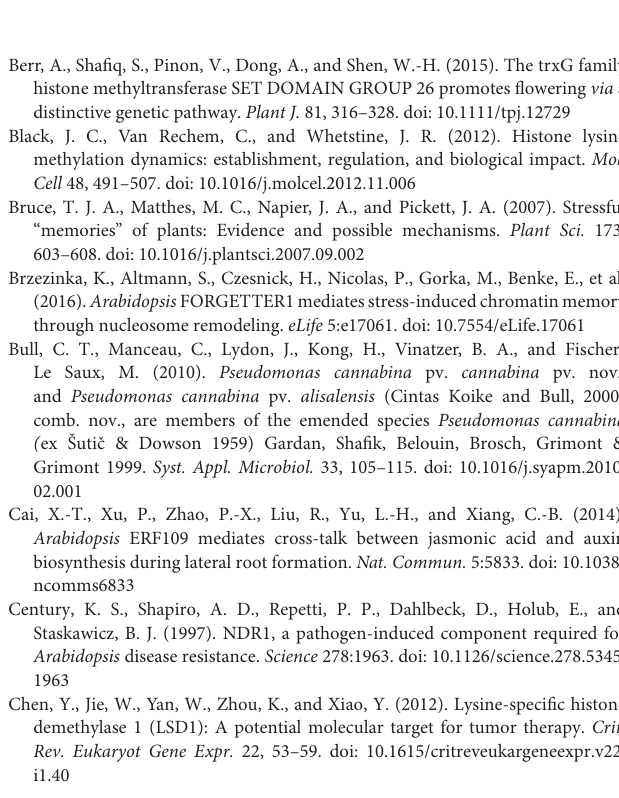
Supplementary Figure 3 | Transcript levels of MAMP-responsive genes in local leaves of WT and mutant plants upon infection with virulent strain Psm ES4326 (OD 600 = 0.01). (A - C) Each plot is representative of one of the four independent biological replicates of FRK1 (A) , NHL10 (B) , and At1g51890 (C) shown in Figure 3C . Bar indicates the SD ( ∗ p < 0.05, ∗∗ p < 0.01, two-tailed Student’s t -test, n = 3). Supplementary Figure 4 | Transcript levels of defense-related genes in distal systemic leaves of WT and mutant plants upon challenge-inoculation with virulent Pseudomonas . (A,B) Each plot represents the other biological repeat of PR1 (A) , and FRK1 (B) in Figures 4C,D . (C,D) Transcript levels of NPR1 (C) and WRKY70 (D) in distal leaves during SAR. Bar indicates the SD ( ∗ p < 0.05, ∗∗ p < 0.01, two-tailed Student’s t -test, n = 3). Supplementary Figure 5 | GO analysis of DEGs in ldl1 ldl2 mutants and identification of LDL1- and LDL2-target genes that function in plant immunity. (A - C) Gene Ontology (GO) enrichment by the Panther classification system (Szklarczyk et al., 2019) of 273 DEGs in the biological process (A) , molecular function (B) , and protein class (C) categories in ldl1 ldl2 compared with WT. Annotated terms with p < 1.E-04 (A,B) and p < 2.51E-03 (C) are listed. ( D ) Venn diagram of DEGs in ldl1 ldl2 and LDL1-target genes. DEGs identified by microarray analysis of ldl1 ldl2 mutants (Berr et al., 2015) and using ChIP-seq data obtained from LDL1-GFP expressing plants (Hung et al., 2018) were compared with DEGs in the ldl1 ldl2 mutant identified by RNA-seq analysis. Numbers in parentheses are the total numbers of genes identified in each study. (E) 23, 11, and 8 genes involved in ‘response to stimulus’ (red dot), ‘DNA-binding transcription factor activity’ (blue dot), and ‘response to chitin and to bacterium’ (green dot), respectively, and their False Discovery Rates (FDR) are shown in the table. Supplementary Figure 6 | STRING analysis of 39 DEGs and representative defense-related genes. (A) Thirty-nine proteins that are putative targets of LDLs ( Table 1 ) were subjected to protein-protein interaction network functional enrichment analysis via STRING (Mi et al., 2013). Dots represent the putative functions of these proteins, including ‘response to stimulus’ (red dots),